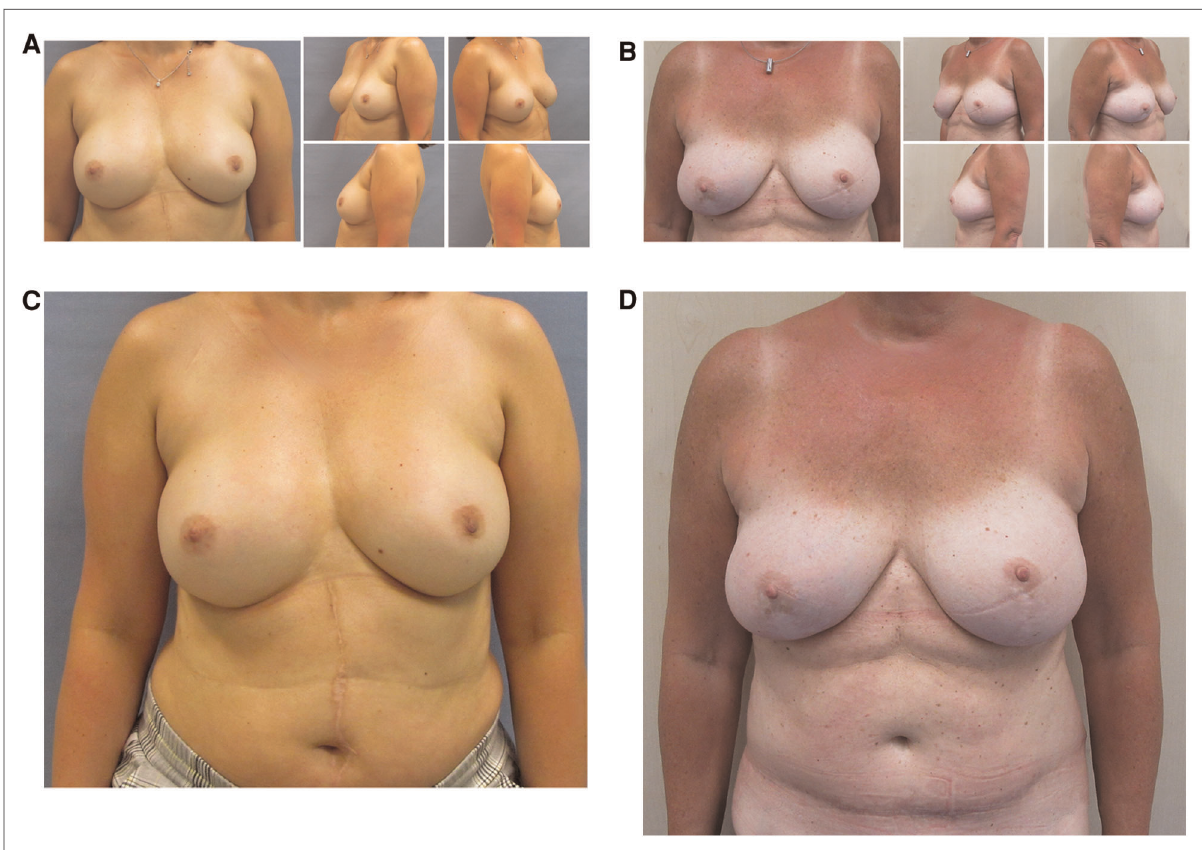
FIGURE 1 Aesthetic evaluation: pass 1 with photographs above the waistline with no hint for the performed procedure and pass 2 with appearance of the whole upper body. ( A ) 47-year-old patient with bilateral skin-sparing mastectomy and nipple-grafting after right-sided breast cancer and uncomplicated prepectoral implant-based reconstruction. Aesthetic sum score pass 1 (above the waistline): 4.60. Aesthetic sum score pass 2 (whole upper body): 5.00 ( B ) 53-year-old patient with bilateral prophylactic uncomplicated nipple-sparing mastectomy and DIEP reconstruction. Aesthetic sum score pass 1: 4.80, aesthetic sum score pass 2: 4.60. ( C , D ) Photographs of the whole upper body of the before-mentioned patients within aesthetic evaluation pass